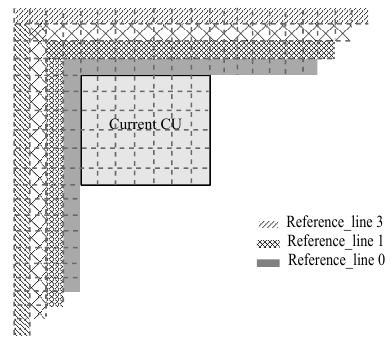
Figure 2. Reference lines neighbouring to an intra-predicted